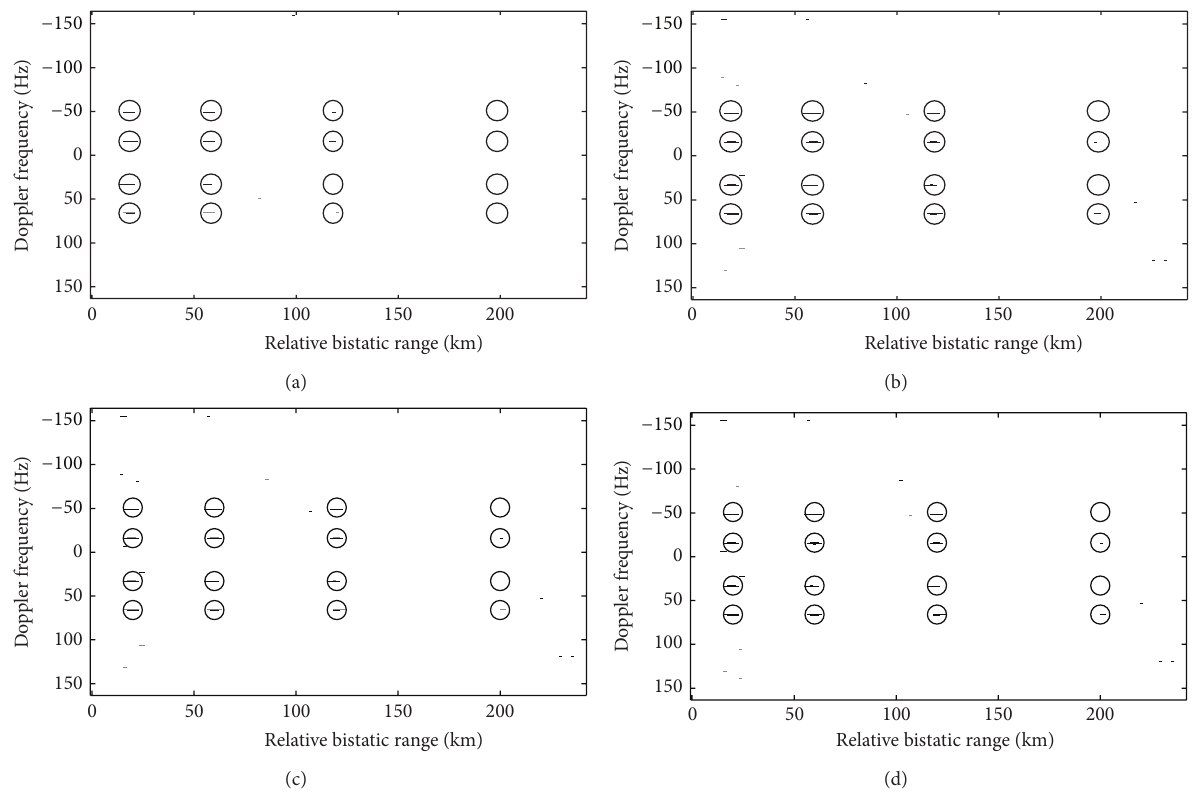
Figure 9: Detection results in the absence of stationary obstacles for (a) side lobe control by central element tapering (nonadaptive), (b) optimum filter, (c) principal eigenvalue approach, and (d) SLC.